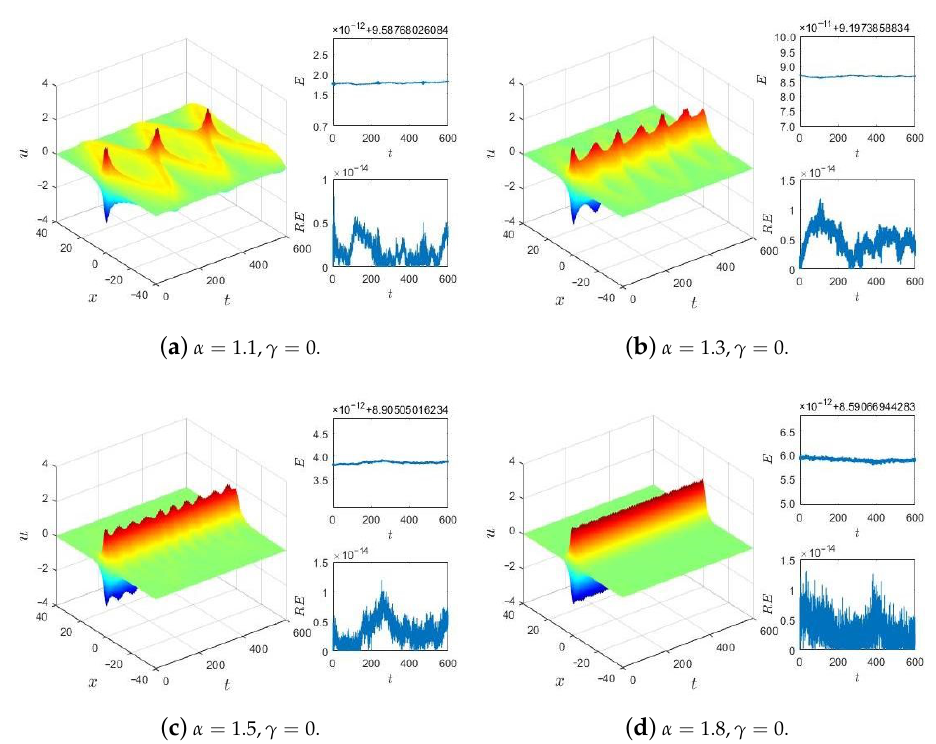
Figure 1. Surfaces of numerical solution, the discrete energy E n , and the relative errors of the discrete energy RE n for γ = 0 and different α with h = 1/4 and τ =